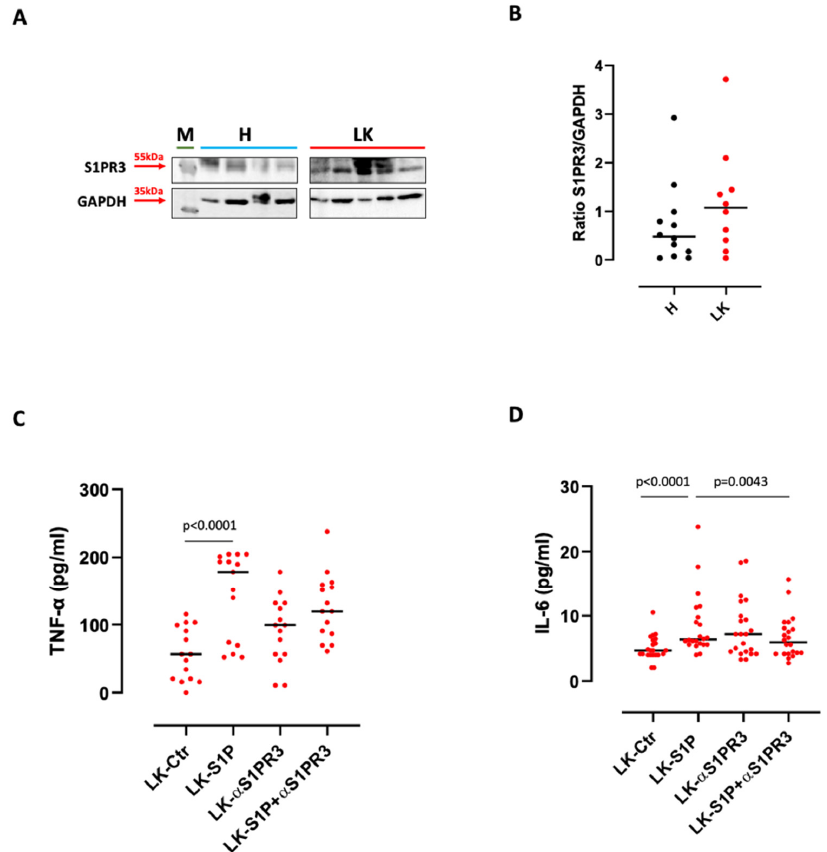
Figure 2. S1P-induced pro-inflammatory cytokine release was S1PR3 dependent. ( A ) Western blotting shows that healthy volunteers (H)-derived PBMCs expressed lower levels of S1PR3 compared to lung cancer (LK)-derived PBMCs. GAPDH was used as a loading control. The experiment was repeated three times. M refers to protein molecular weight marker. ( B ) S1PR3 expression analysis was performed by means of ImageJ software (NIH, USA) and expressed as a ratio between S1PR3 and GAPDH (loading control). S1PR3 inhibition with TY52156 ( α S1PR3, 10 µ M) reduced the release of TNF- α ( C ) and IL-6 ( D ) from LK-derived PBMCs after S1P (10 nM) addition. We used match-paired LK samples. n = 15 LK (Ctr-S1P) were tested for TNF- α ( C ) and n = 22 LK (Ctr-S1P) were tested for IL-6 ( D ). Data are represented as scatter dot plots indicating the median (confidence interval = 95%). Statistical differences were assessed by means of two-tailed Wilcoxon matched-pairs signed rank